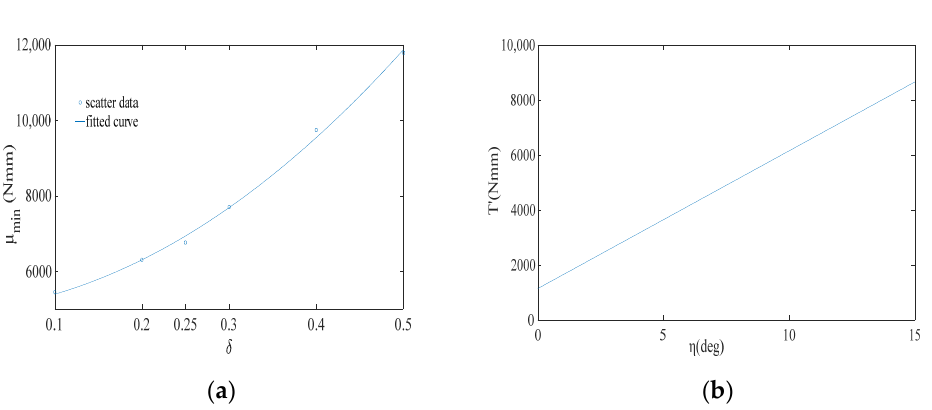
 of each  for the knee joint; ( b ) torque of the torsional spring. Figure 9. ( a ) µ min of each δ for the knee joint; ( b ) torque of the torsional Figure 9. ( a ) min